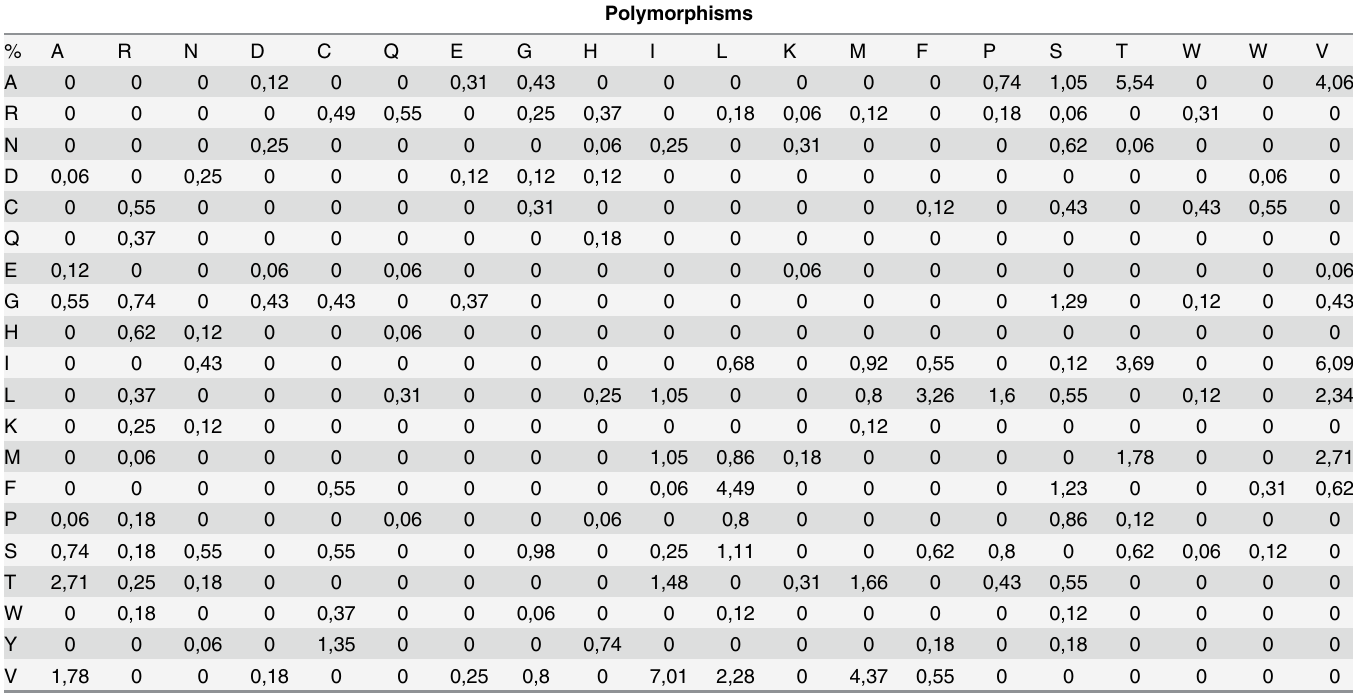
Table 3. Relative frequency of amino acid substitutions. Mutated amino acids are shown in rows; mutant amino acids are shown in columns associated with